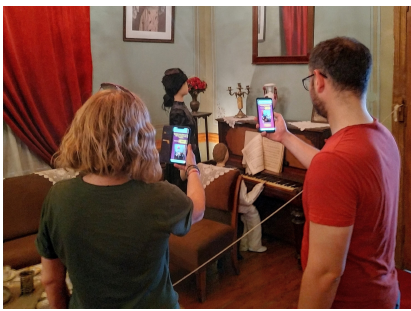
Figure 1. An instance of the proposed YPOPSEI system’s deployment. The user is able to retrieve information regarding an exhibit through a minimal number of interactions on his/her personal mobile